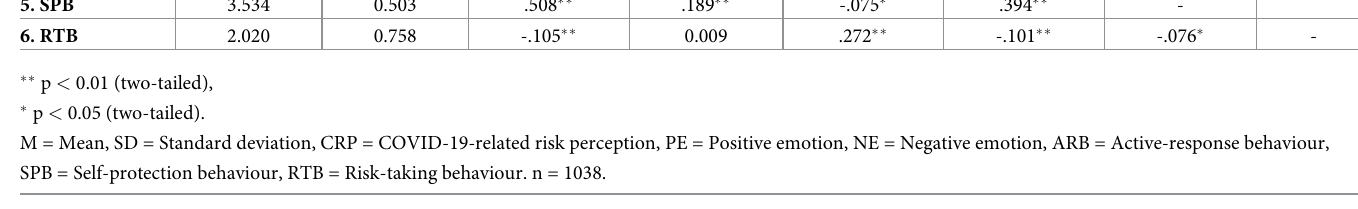
(41.23%) were freshmen. Their ages ranged from 17 to 26 years (Mean [M] = 20.5, Standard Deviation [SD] = 2.69). The sample is consistent with the local population distribution charac- teristics. Further, 20 (1.90%) participants lived in Wuhan (capital of Hubei province), 124 (11.95%) were from other areas in Hubei, and 894 (86.10%) were from various areas in China. Among them, 268 (25.82%) were from COVID-19 high-risk areas (CHRAs), 291 (28.03%) were from COVID-19 medium-risk areas (CMRAs), and 438 (42.20%) were from COVID-19 low-risk areas (CLRAs); one had missing data.